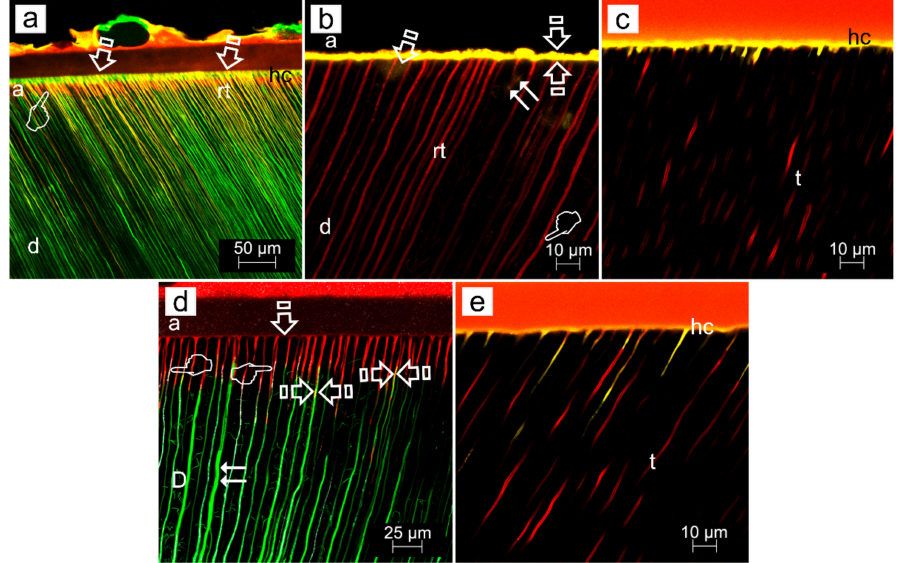
Figure 6. ( a ) CLSM image (reflexion/fluorescence) showing the interfacial characterization and micropermeability of the resin sound dentin-interfaces of SEB, after 24 h of storage, exhibiting micropermeability (arrows) between dentin ( d ) and the adhesive layer ( a ). A limited nanoleakage signal from the hybrid complex (pointer) (hc) may be observed. The adhesive layer showed thin resin tags (rt) when imaged in rhodamine excitation/emission mode (Scale bar: 50 µ m). ( b ) CLSM single-projection image discloses the fluorescent calcium-chelators dye xylenol orange. It is observed the interfacial characterization of the resin/sound dentin interface created using SEB · P-ZnO and mechanical load cycling. Very little micropermeability and nanoleakage (arrow) between dentin ( d ) and the adhesive layer ( a ), and within the dentinal tubules (t) (double arrows), is shown. The presence of some obliterating mineral segment, is adverted (pointers). The adhesive layer displays an intense spectral overlap (yellow) (faced arrows). Long resin tags (rt) are also discernible (scale bar 10 µ m). ( c ) CLSM single-projection images disclose the fluorescent calcium-chelators dye xylenol orange. The interfacial characterization of the resin/caries-affected dentin interface created using SEB · P-ZnCl 2 adhesive applied on smear layer-covered dentin, and then load cycled, imaged in Rhodamine excitation/emission and calcium-chelators dye xylenol orange modes (SEB · P-ZnCl 2 · Xo,) is shown. The interface discloses a clear fluorescence signal within the hybrid complex (hc) and dentinal tubules (t) (Scale bar: 10 µ m). ( d ) CLSM image (reflexion/fluorescence) of the interfacial characterization and micropermeability of the resin/carious-affected dentin-interface of SEB · P-ZnO and mechanically load cycled. Any micropermeability and nanoleakage (arrow) between dentin (D) and the adhesive layer ( a ), but within the dentinal tubules (t) (double arrows), is shown. No further dye diffuses into the adhesive layer and a powerful reflective signal within the dentinal tubules (pointers) is observed. Some resin tags show an intense spectral overlap (yellow) (faced arrows) (Scale bar: 25 µ m). ( e ) CLSM single-projection image discloses fluorescent calcium-chelators dye xylenol orange. The interfacial characterization of the resin/caries-affected dentin interface created using SEB · Bd-ZnCl 2 adhesive applied on smear layer-covered dentin, and then load cycled, imaged in Rhodamine excitation/emission and calcium-chelators dye xylenol orange modes (SEB · Bd- ZnCl 2 · Xo) is shown. The interface exhibits a clear fluorescence signal inside the hybrid complex (hc) and dentinal tubules (t) (Scale bar: 10 µ m). All figures were obtained at 63x-2 with optical zoom at 10 µ m of scale bar. a, adhesive layer; d, dentin; hc: hybrid complex; rt, resin tags; t, dentinal tubules. Previous to adhesive application, bond resins were doped with 0.05 wt% Rhodamine-B, or immersed in 0.5 wt% xylenol orange solution. Fluorescein was activated by blue light (488–495 nm) and emitted yellow/green (520 nm). The ultramorphology evaluation (resin-diffusion) was executed using Rhodamine excitation laser. Fluorescences were or not separated into spectral regions to permit the operator a full control of the region of the light spectrum directed to each channel. More information about the used CLSM technique is provided at reference